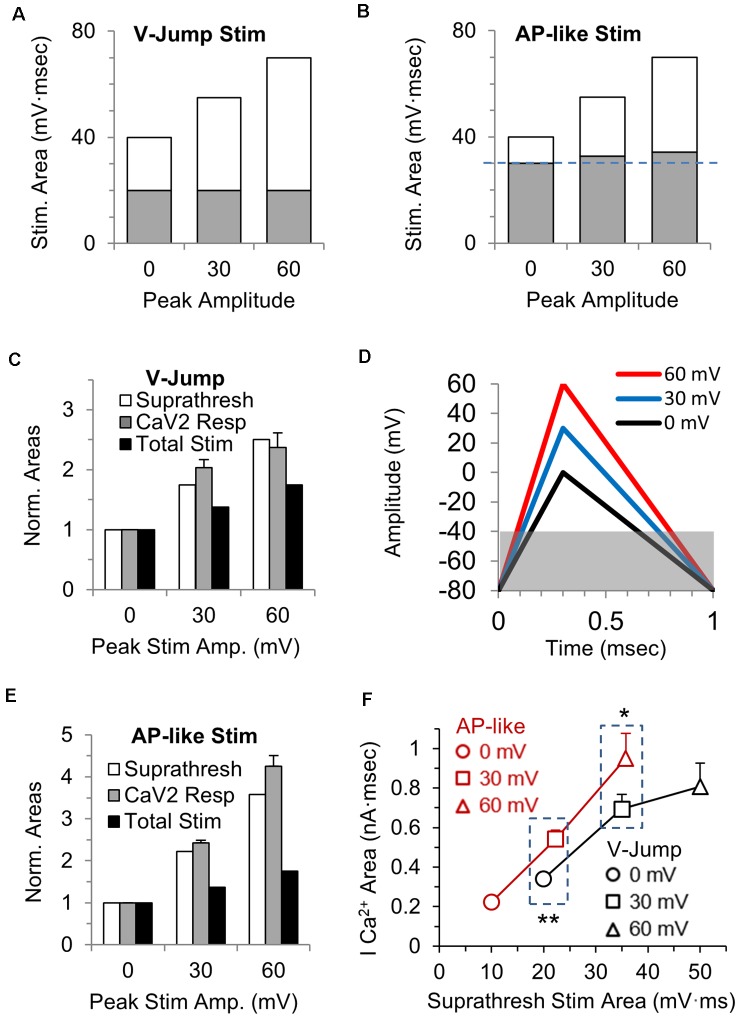
Stimulus area above −40 mV correlates with the area of the calcium channel response. (A) The total area of each voltage-jump stimulus, with the portion of the stimulus that is above the threshold for calcium channel activation shown in white, and the portion below threshold in gray. (B) The total area of each AP-like stimulus, with the portion of the stimulus above the threshold for calcium channel activation shown in white, and the portion below threshold in gray. The subthreshold area increases slightly (see panel D) as the AP-like stimulus amplitude increases (blue dashed line). (C) The suprathreshold stimulus area of each voltage-jump stimulus (white), the calcium current integral (gray) and the total stimulus area (black) at 30 and 60 mV were normalized to the value at 0 mV; n = 5 cells, from Figure 1F. The graph allows a comparison between the relative changes in the total or suprathreshold stimulus areas to the relative changes in calcium influx. (D) AP-like stimulus with peak amplitudes of 0 (black), 30 (blue) or 60 mV (red). Panels (D–F): n = 5 cells, from Figure 1F. The gray box indicates the subthreshold portion of the stimulus, and how the subthreshold area differs between these stimuli. (E) The suprathreshold stimulus area of each AP-like stimulus (white), the calcium current integral (gray) and the total stimulus area (black) at 30 and 60 mV were normalized to the value at 0 mV. The graph allows a comparison between the relative changes in the total or suprathreshold stimulus areas to the relative changes in calcium influx. (F) Direct comparison of the calcium current areas and suprathreshold stimulus areas for voltage jump vs. AP-like stimulation with peaks amplitudes of 0, 30 and 60 mV. Note that the suprathreshold stimulus area are similar for a 0 mv voltage jump and a 30 mV AP-like stimulation (left box); and are also similar for a 30 mV voltage jump and a 60 mV AP-like stimulation (right box). At similar suprathreshold areas, the AP-like stimulation allows more calcium entry. *p < 0.05; **p < 0.01.